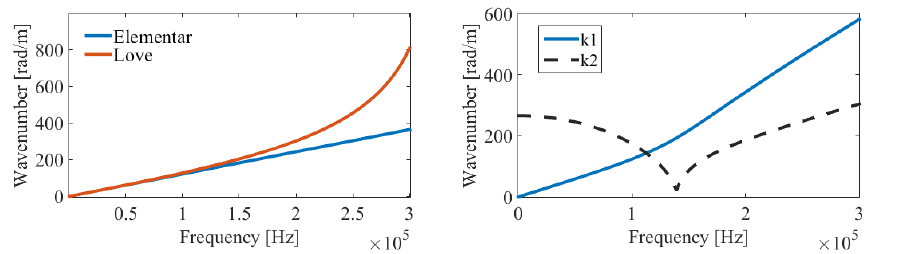
Figure 6. Elementar and Love rods dispersion diagram on LHS and Mindlin-Herrmann rod on RHS.